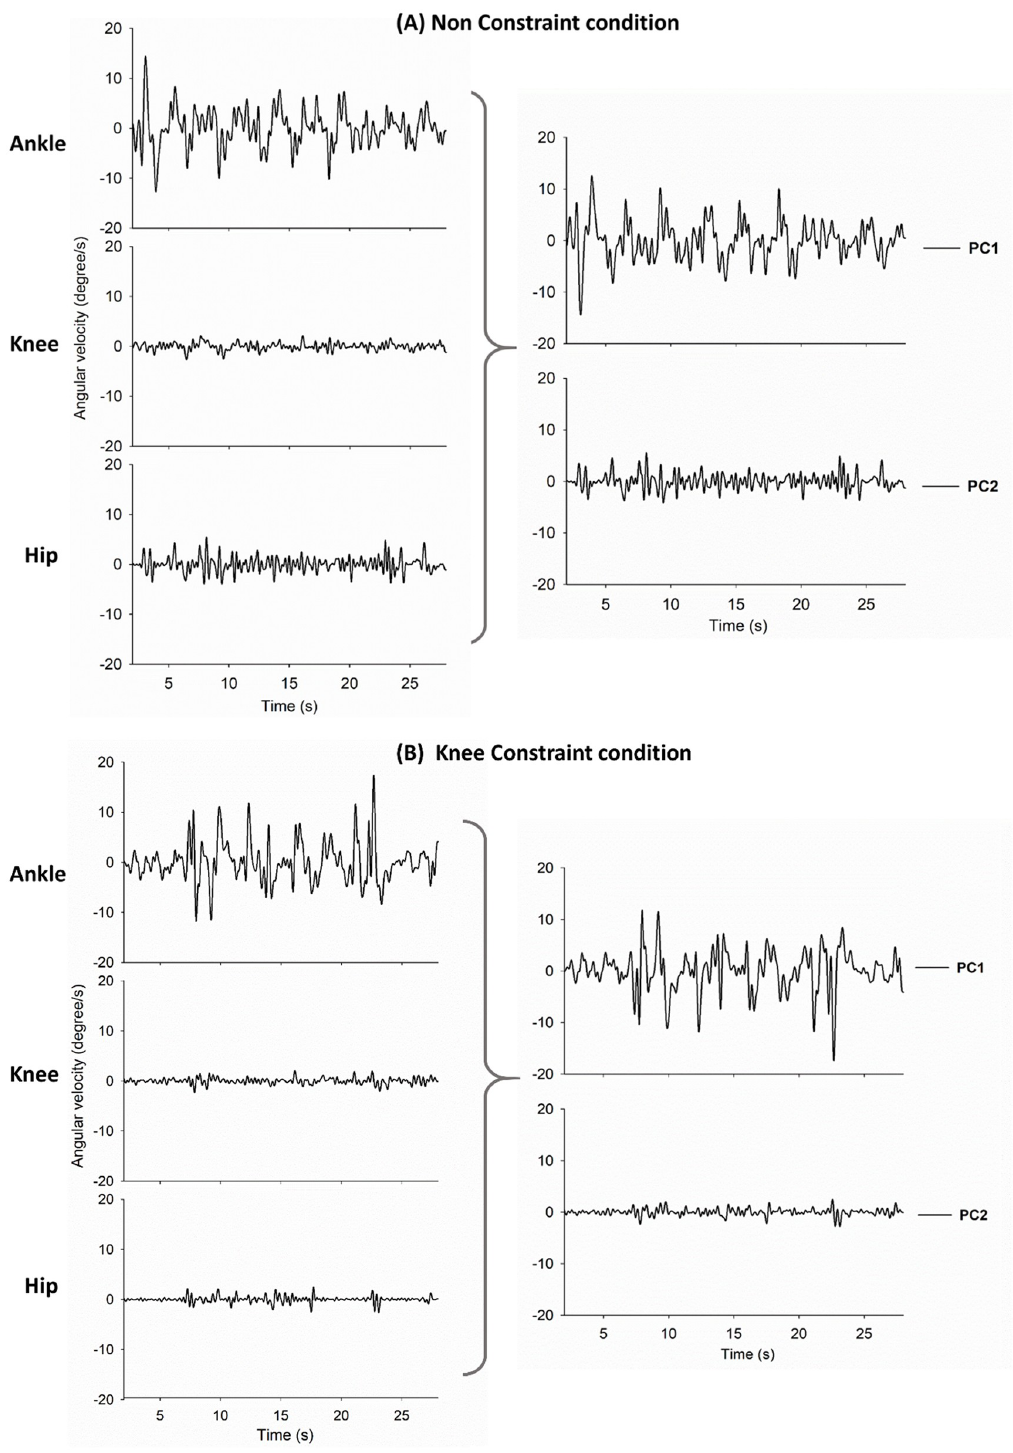
Fig 2. Illustration of a typical trial as an example to demonstrate the NC (A) and KC (B) conditions. Illustration of individual joint angular velocities in one example trial (left plots). Illustration plots of 1 st and 2 nd principal components (right